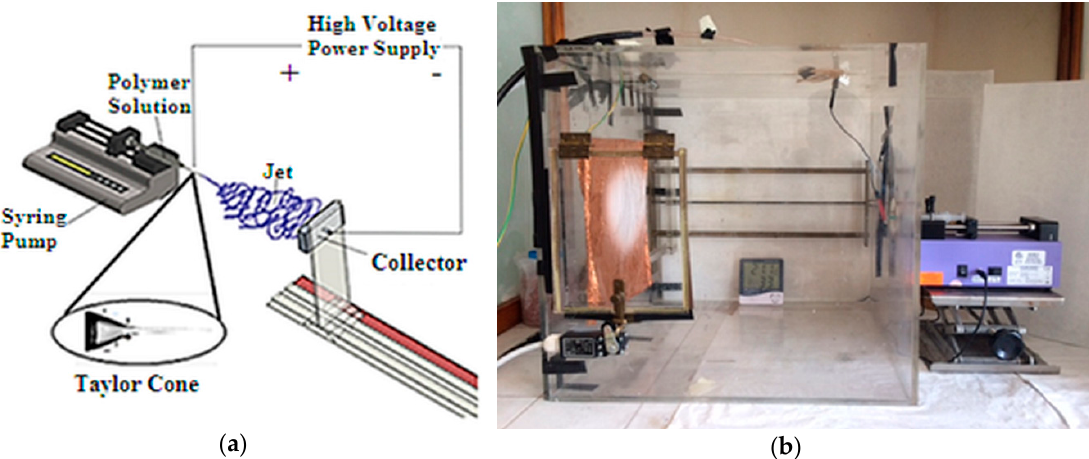
Figure 1. E lectrospinning apparatus. ( a ) Schematic setup; ( b ) Laboratory setup. Figure 1. Electrospinning apparatus. ( a ) Schematic setup; ( b ) Laboratory